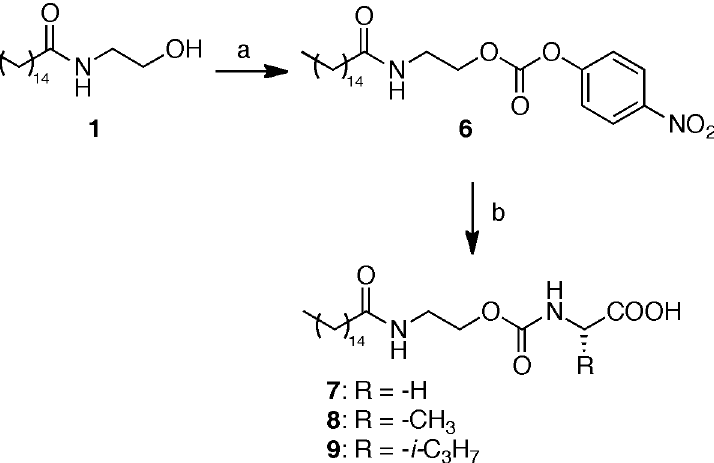
Fig 4. Synthesis of carbamates 7 – 9. Reagents and conditions: (a) p-nitrophenyl chloroformate, pyridine, DCM, 0°C to rt, 3 h; (b) RCH(NH 2 )COOH, Na 2 CO 3 , tert -butanol, water, 50°C, 12 h.